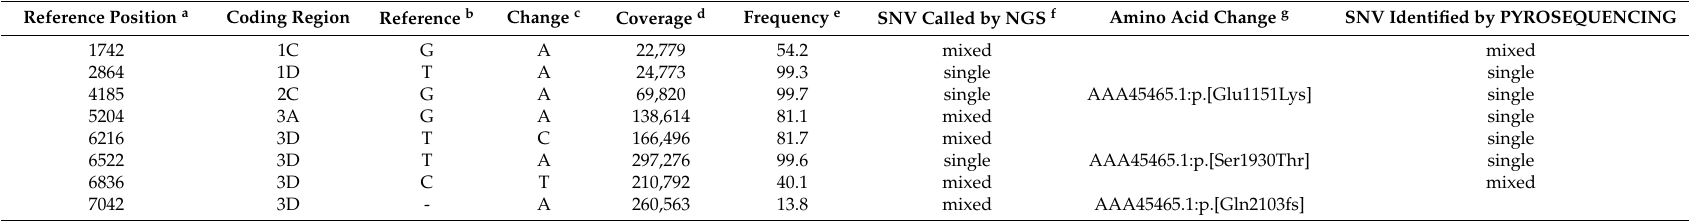
Table 1. Identification of single nucleotide variations (SNVs) present in viral RNA extracted from a Hepatitis A virus (HAV) HM175 positive stool sample. NGS = next-generation